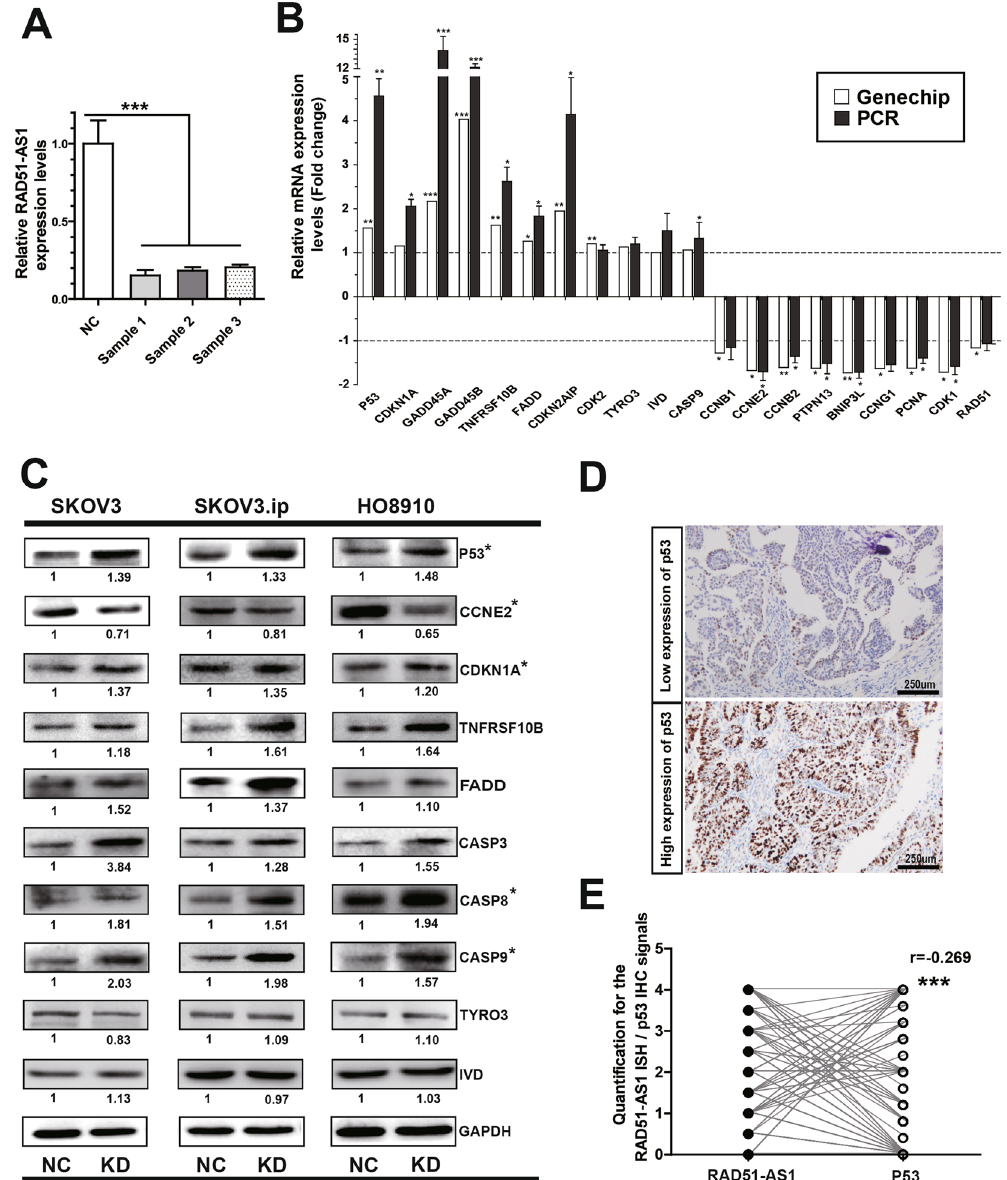
Figure 5. RAD51-AS1 silencing regulates the expression of p53 and p53-related genes. ( A ), The silencing efficiency of RAD51-AS1 in microarray samples was validated by qRT-PCR. ( B ), The mRNA levels of p53- related genes in SKOV3.ip cells were detected by qRT-PCR after RAD51-AS1 knockdown. The results confirm the microarray data, and the mRNA level of predicted RAD51-AS1 target genes (TYRO3 and IVD) was not affected. ( C ), The protein levels of p53-related genes were detected by Western blotting after RAD51-AS1 knockdown. No changes were observed in the protein levels of TYRO3 and IVD. ( D ), Representative p53 IHC images in EOC patient samples. ( E ), The correlation between p53 and RAD51-AS1 expression in patient samples (Spearman Correlation analysis, P < 0.001, r = − 0.269). All results are shown as the mean ± SD and are representative of three independent experiments. ( * P < 0.05; ** P < 0.01; *** P < 0.001 by Student’s t